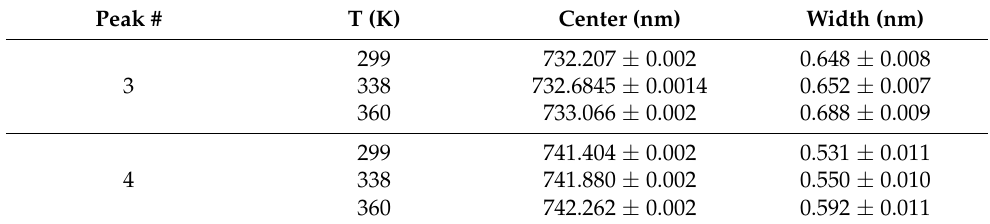
Table 2. Lorentzian fit parameters to PL curves excited with different powers, as shown in Figure 4d. Peak # T (K)